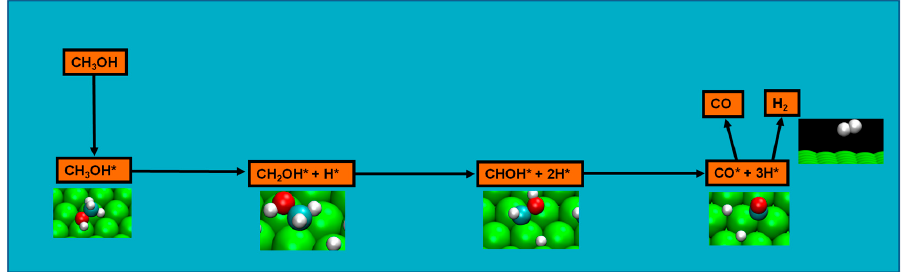
Figure 4. Representation of the methanol decomposition via hybrid route (II). Red color stands for oxygen, blue for carbon, white for hydrogen and green for ruthenium.